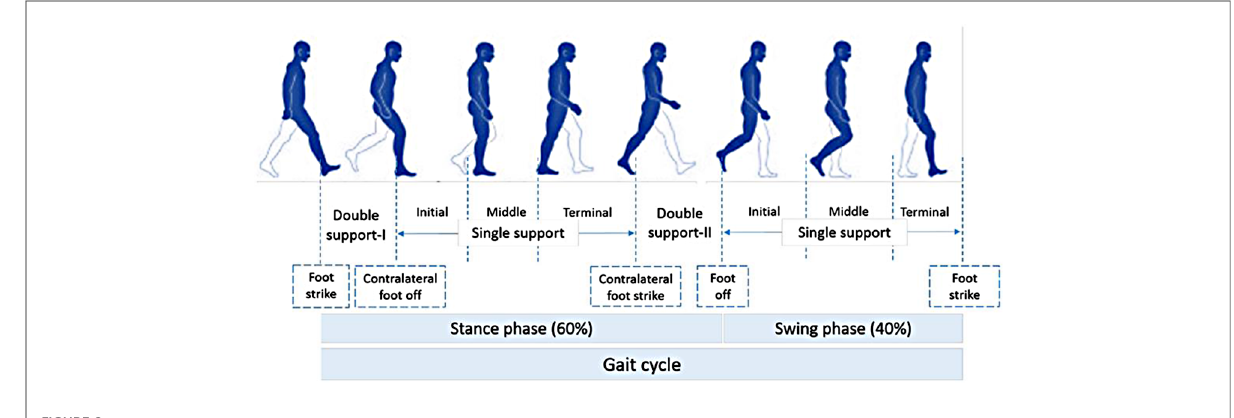
FIGURE 2 Normal gait cycle (adapted from